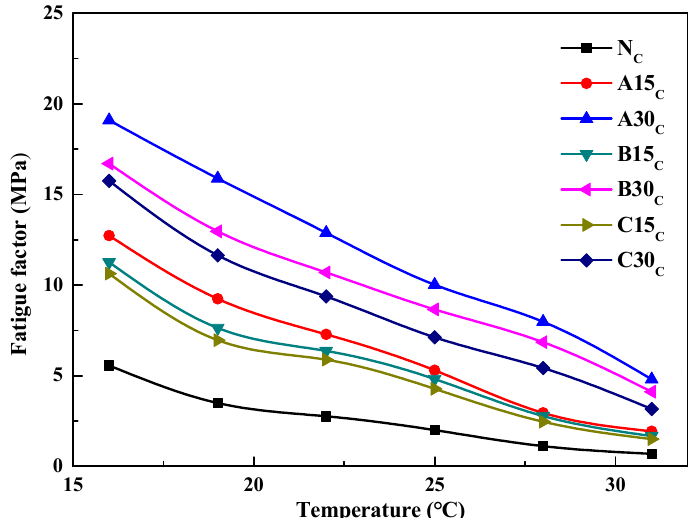
Figure 7. Variation of ∆ G*sin δ for asphalt versus temperature. Table 6. Analysis of variance results for reclaimed asphalt ∆ G*sin δ and G*sin δ .